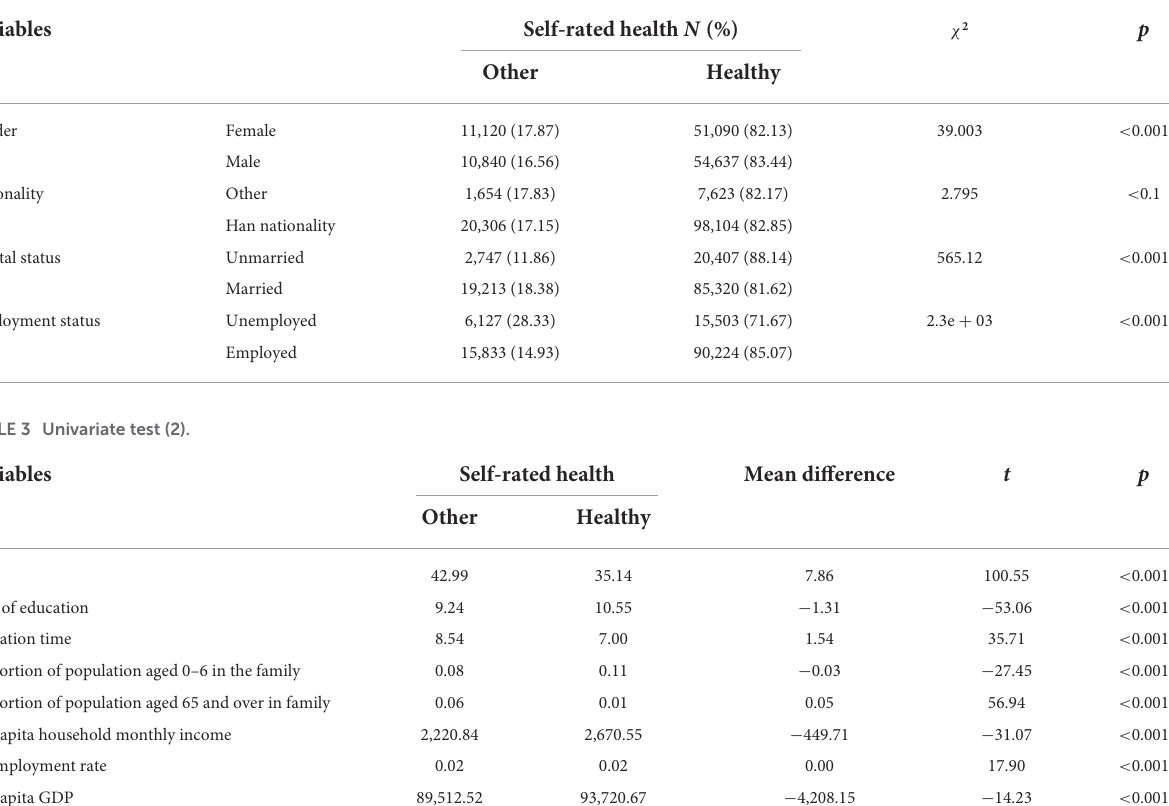
TABLE 2 Univariate test (1).